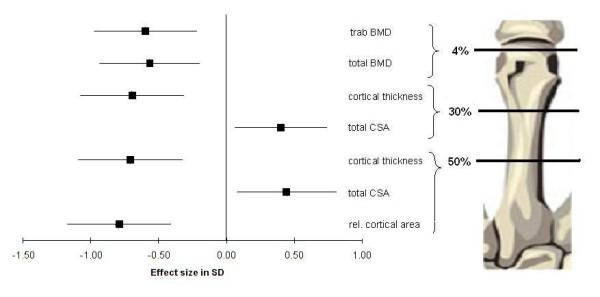
Effect size of bone parameters at the metacarpal bone between RA patients and healthy controls. The error bars indicate 95% confidence interval of the between group differences in mean SD of both groups.